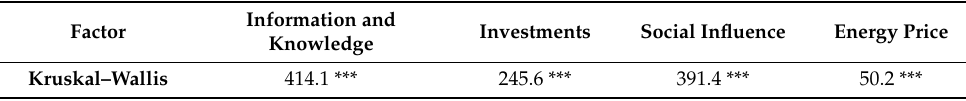
Table 4. Results of Kruskal–Wallis test.